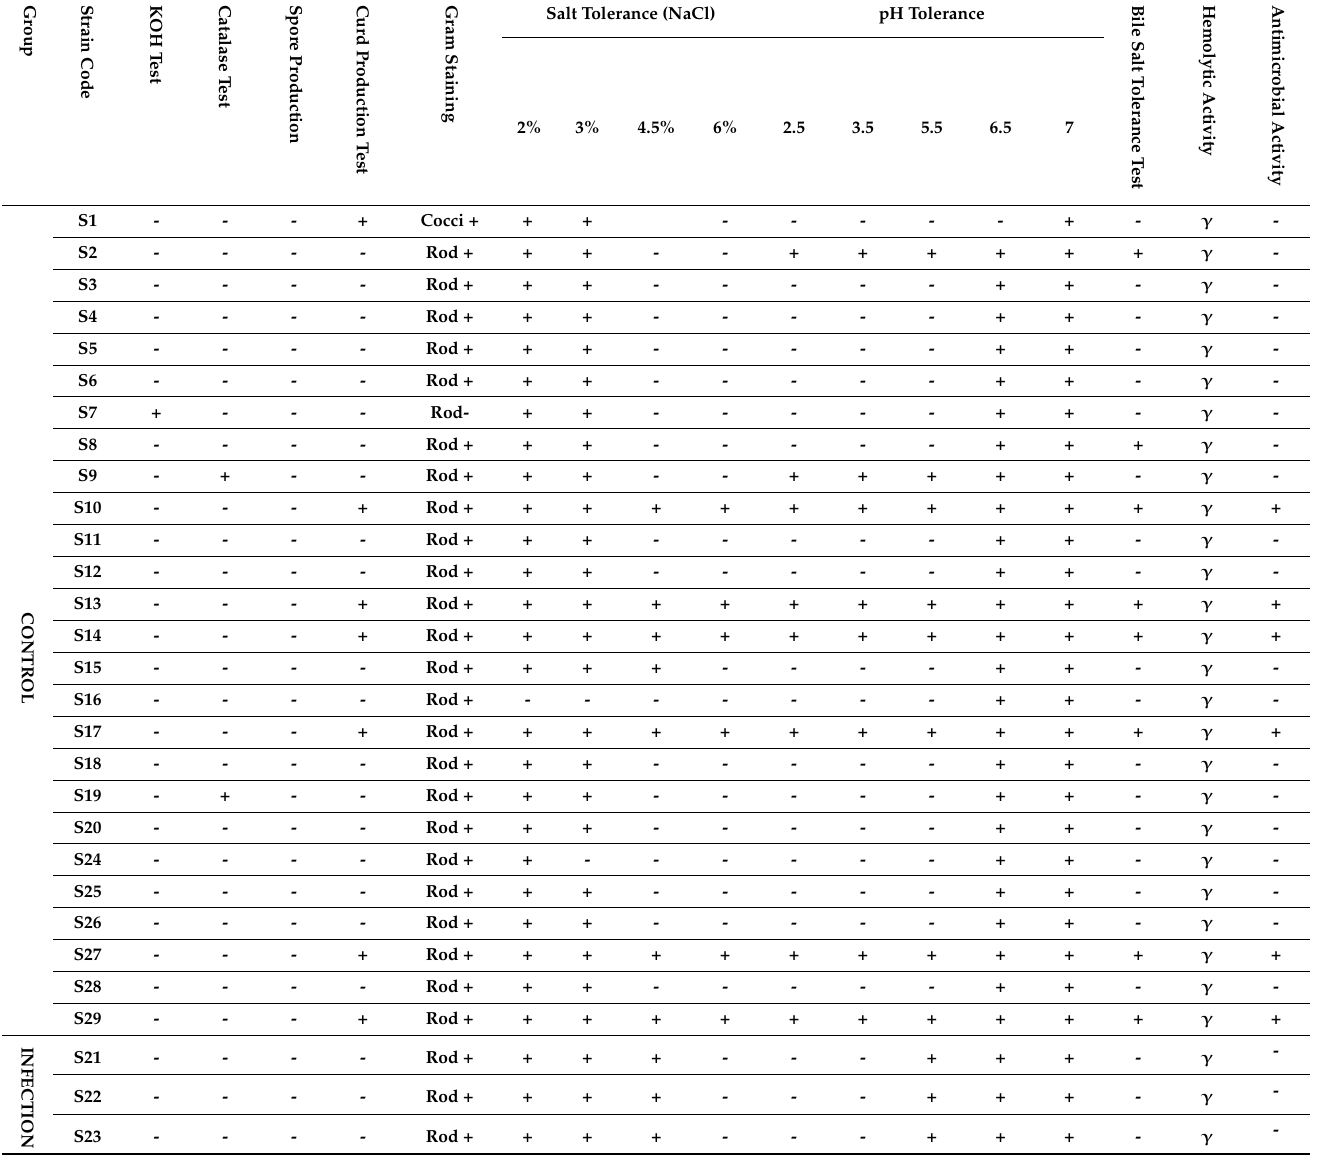
Table 1. Probiotic confirmatory test of 29 isolates.